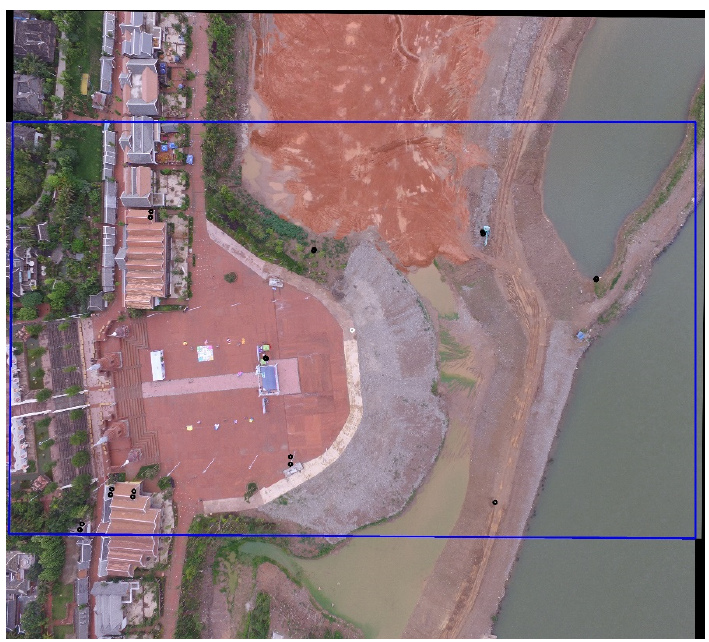
Figure 5. Manually selected feature points in two images.